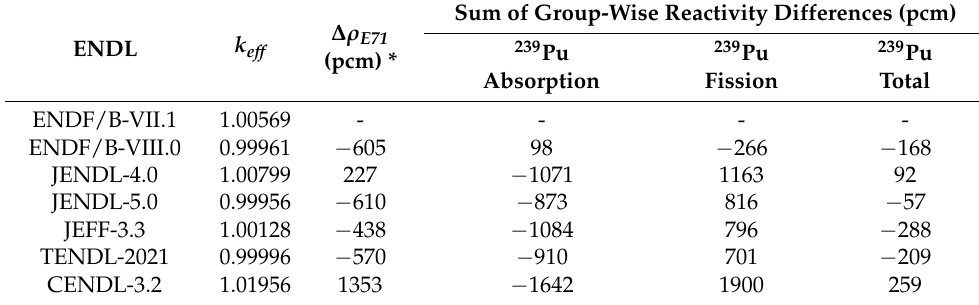
Figure 8. The reactivity difference due to the difference of 239 Pu fission cross sections between ENDF/B-VII.1 and the other ENDL for PNL-5. Table 9. The sum of group-wise reactivity difference due to the difference of 239 Pu fission cross sections between ENDF/B-VII.1 and the other ENDLs for PNL-5.